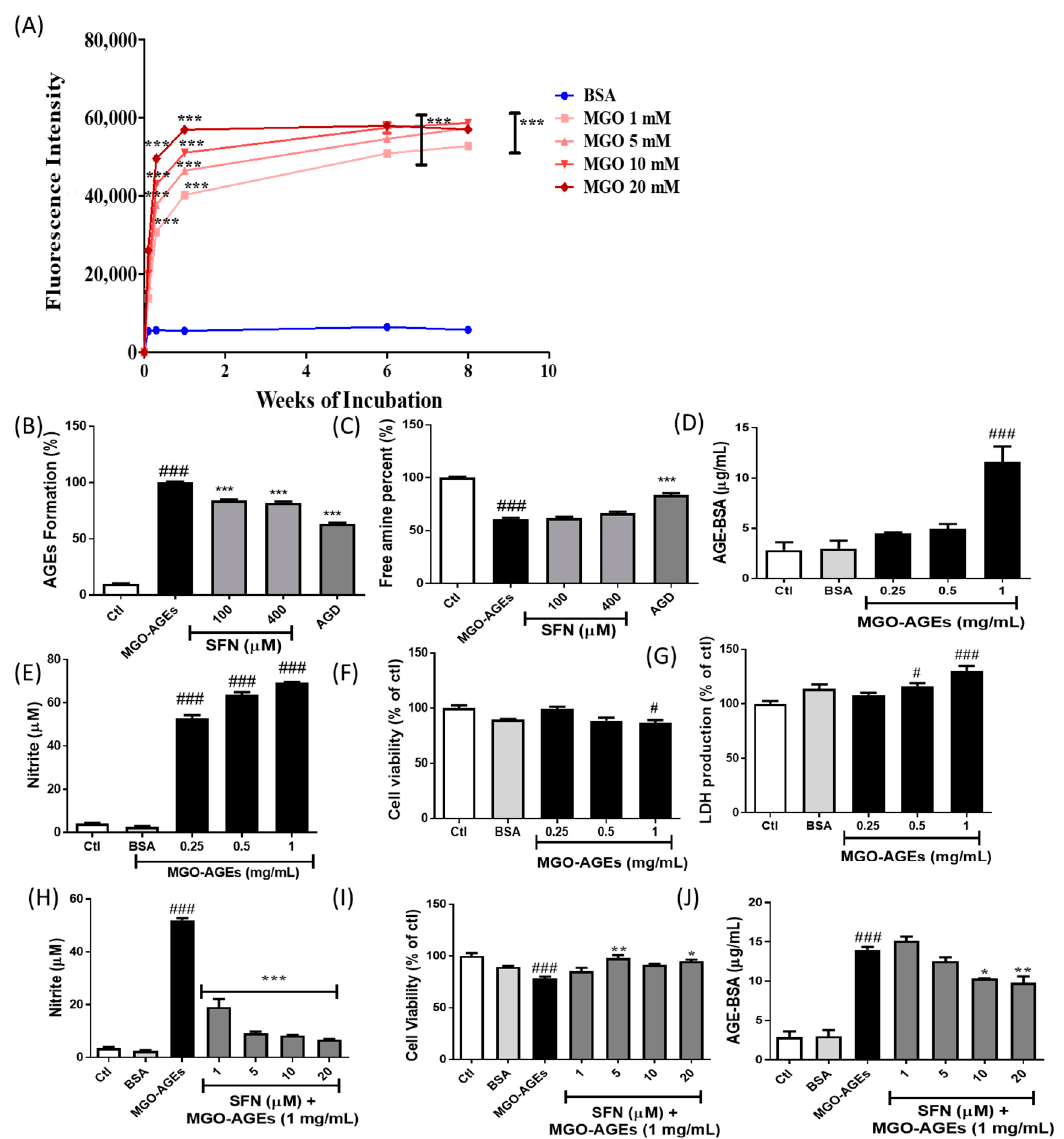
Figure 1. Sulforaphane (SFN) pretreatment reduced the methylglyoxal (MGO)-advanced glycation end product (AGE)-mediated inflammatory cascades in microglial cells. BSA was incubated with MGO (1, 5, 10, and 20 mM) for 8 weeks and formation of MGO-AGEs was determined in a concentration- and time-dependent manner ( A ). SFN was incubated with AGE to determine its effects on AGE formation and breakdown ( B,C ). AGE level was measured by using AGE-competitive ELISA assay ( D ). BV2 cells were treated with various concentrations of MGO-AGEs to determine nitrite production ( E ), cell viability ( F ), and lactate dehydrogenase (LDH) production ( G ). BV2 cells were pretreated with SFN at 30 min prior to MGO-AGEs (1 mg/mL) stimulation and incubated for 24 h to determine effects of SFN on nitrite production ( H ), cell viability ( I ), and AGEs level by AGE-competitive ELISA assay ( J ). * p < 0.05, ** p < 0.01, *** p < 0.001 indicates significant differences compared with AGE alone, whereas # p < 0.05, ## p < 0.01 and ### p < 0.001 indicate significant differences compared with an untreated control group.